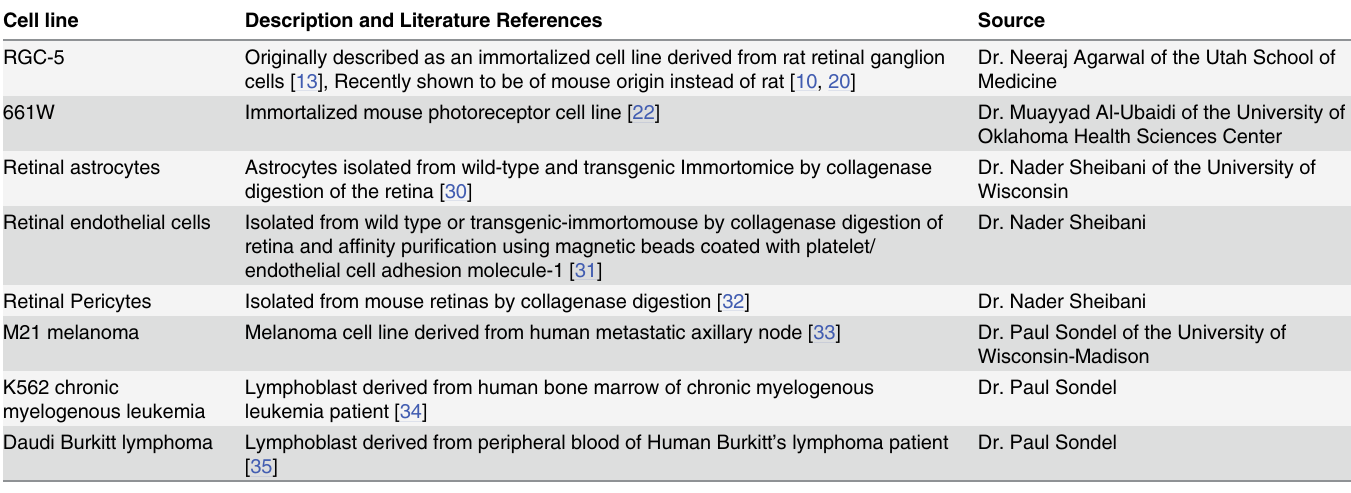
Table 1. Sources and literature references for all cell lines used in the